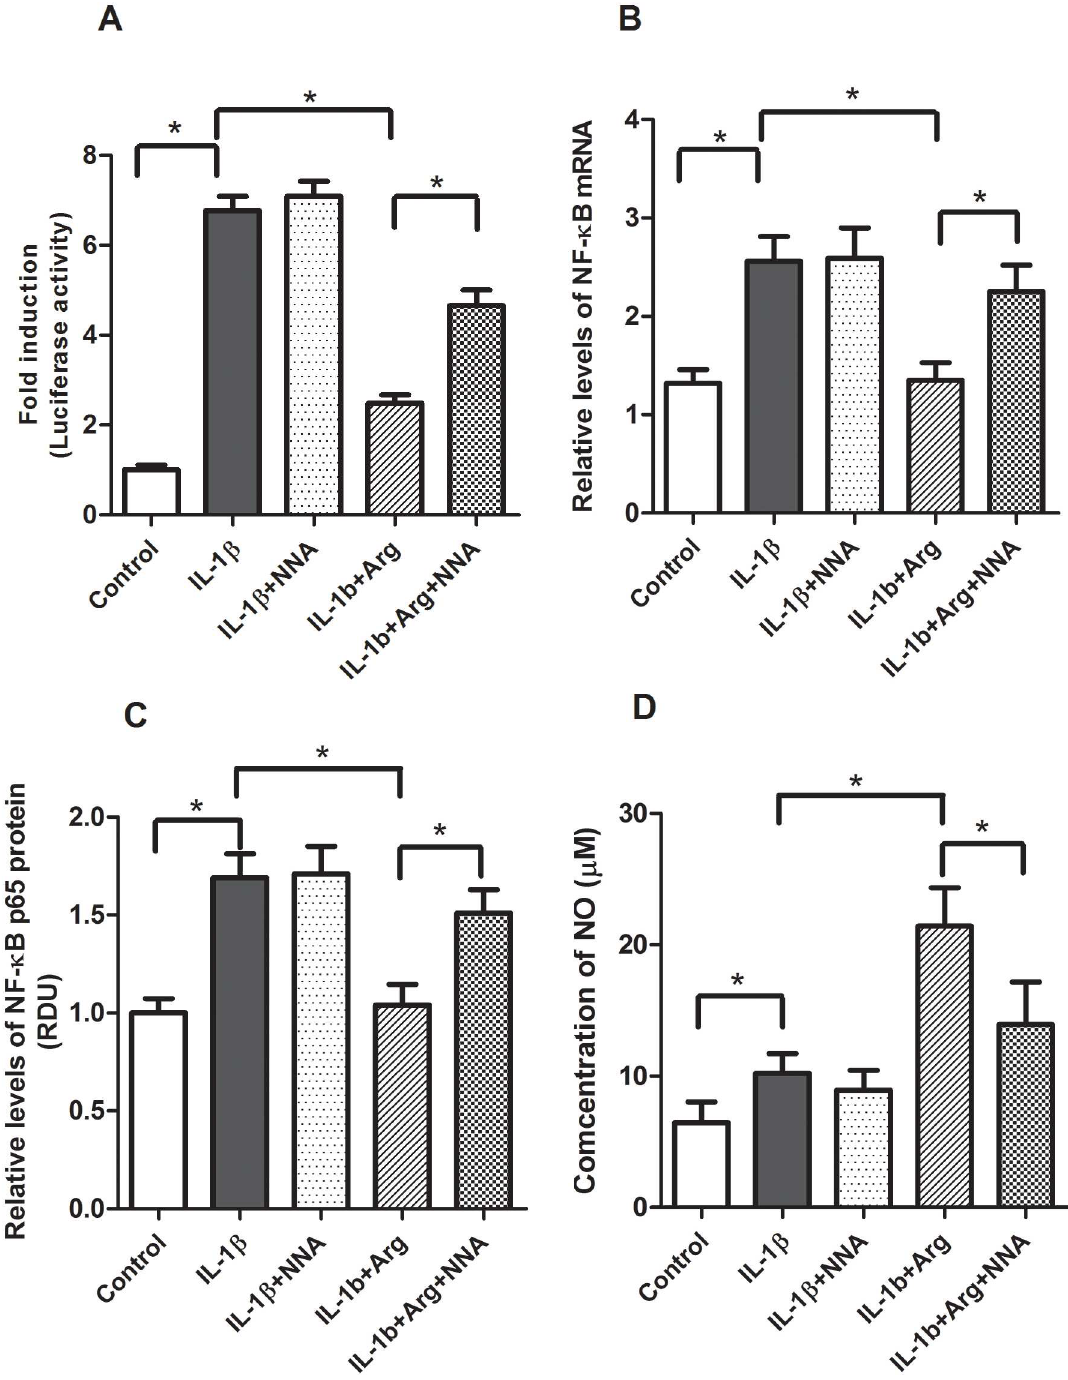
Fig 6. Effects of N ω -Nitro-L-Arginine (NNA) on IL-1 β inducible NF- κ Bpromoter activity, expression and NO production. Caco-2 cells transfected with pNF- κ B-Luc vector were treated with IL-1 β (4 ng/ml) for 4 hours after pretreatment of NNA (0.5 mM) and L-Arg (5 mM) for 4 hours (Fresh medium with NNA and L-Arg was appliedafter removingmedium for pre-treatment). Cells were harvestedfor luciferase activity and isolations of protein and total RNA. A: NF- κ B luciferaseactivity is expressedas fold-induction of normalized luciferase activity. B: NF- κ B mRNA were measuredby qRT-PCR, then normalized to β -actin. C: NF- κ B p65 protein was measuredby Western blot analysisnormalized to β -actin. D: NO levels in cell culture media were measuredas describedin Methods. NNA alone did not affect the LPS-induced NF- κ B promoter activity, NF- κ B mRNA and protein expressionlevels (not shown). Data are means ± SE, * P < 0.05.(n = 4–6 /group).